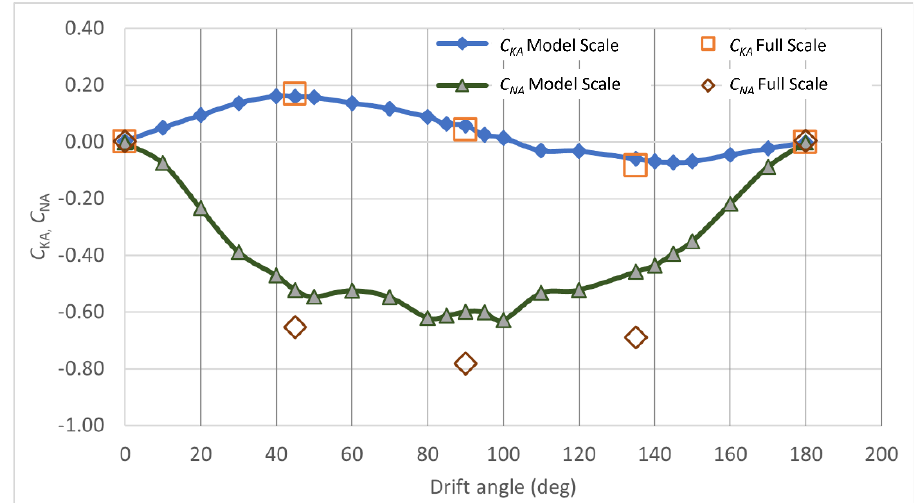
Figure 13. Roll and yaw moment coefficients (aerodynamic) for the Tejo class vessel.